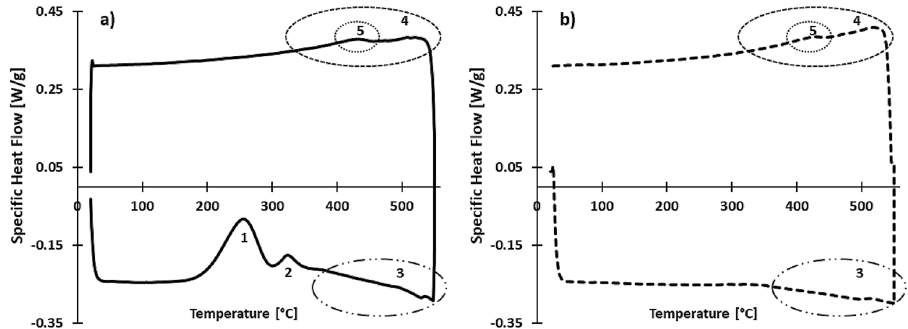
Figure 3. DSC cycles (heating and cooling rate: 20 °C/min) showing the specific heat flow curves of as-built AlSi10Mg: ( a ) first DSC cycle, ( b ) second DSC cycle.